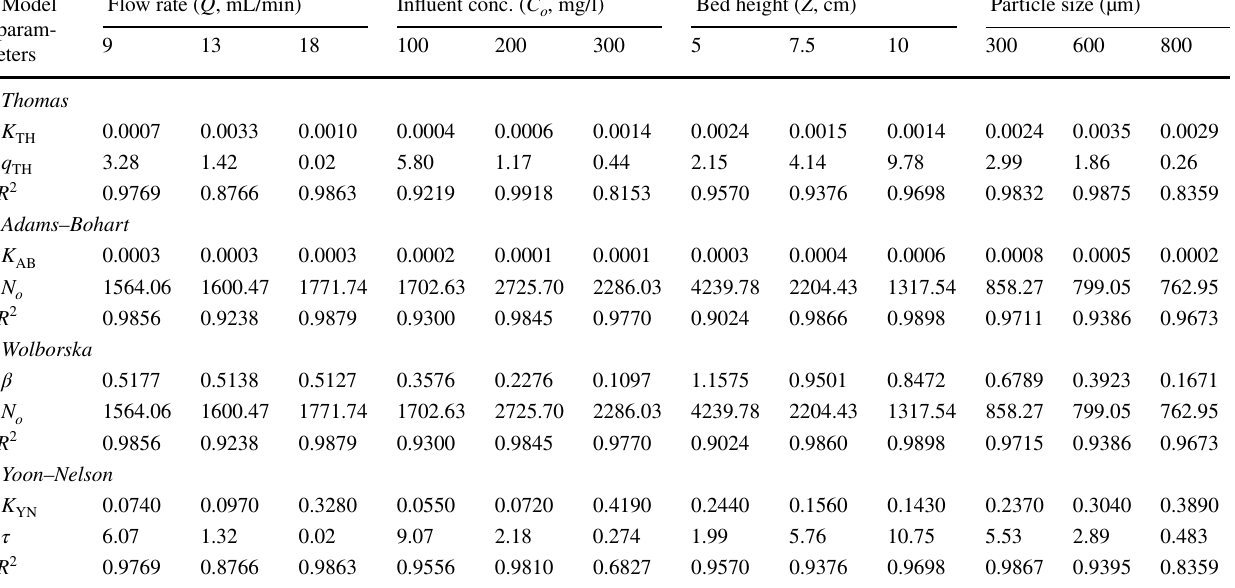
Table 7 Kinetics parameters obtained via linear regression Model